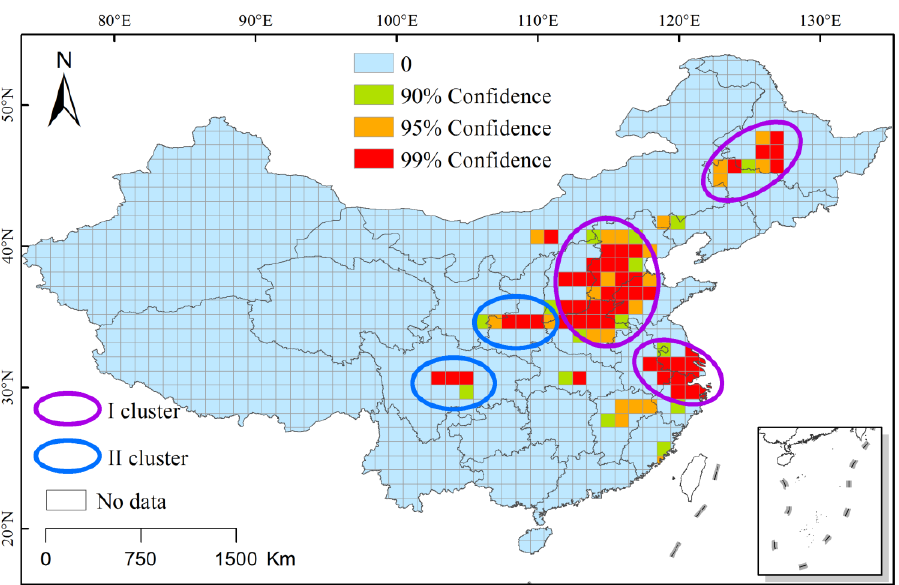
Figure 13. Hotspot analysis of the grid level of urbanization in the TCE. (The red area indicates the hot spot area that passed the 99% confidence test; the yellow area indicates the hot spot area that has passed the 95% confidence test; the green area indicates the hot spot area that has passed the 90% confidence test. The purple circle indicates the hot spots cluster region; the blue circle indicates two secondary hot spots cluster region.)